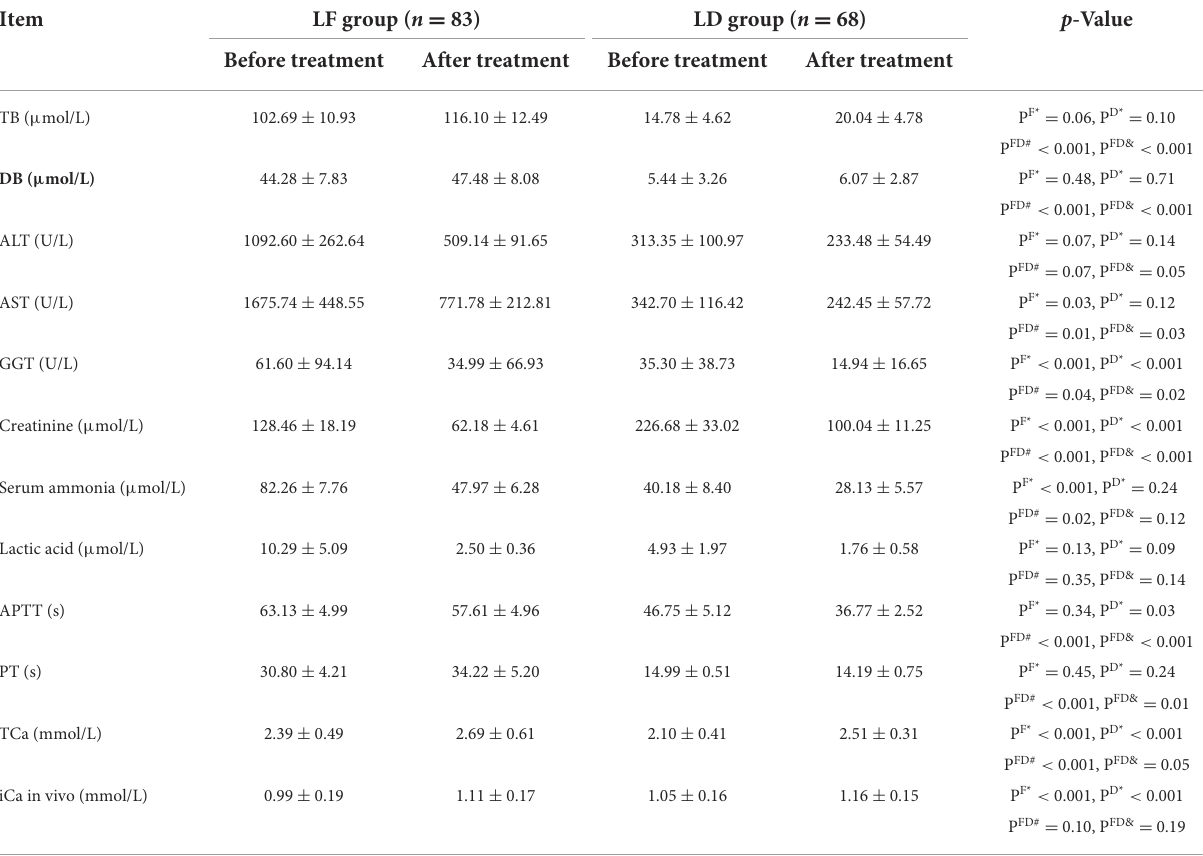
TABLE 3 Biochemical and coagulation indicators of LF group and LD group before and after treatment. Item LF group ( n = 83) LD group ( n = 68) p -Value Before treatment After treatment Before treatment After treatment